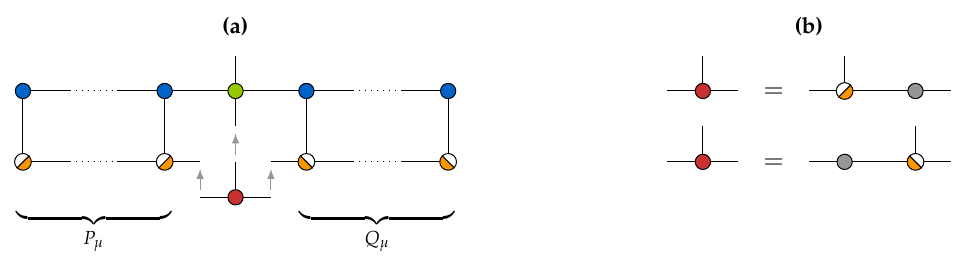
Figure 4. Construction and solution of the subproblem for the µ th core: ( a ) The 4-dimensional core of (cid:98) Ψ X , µ (green circle) is contracted with the matrices P µ and Q µ constructed by joining the fixed cores of the coefficient tensor (orange circles) with the corresponding cores of the transformed data tensor. The matricization then defines the matrix M µ . ( b ) The TT core (red circle) obtained by solving the low-dimensional minimization problem is decomposed (e.g., using QR factorization) into a orthonormal tensor and a triangular matrix. The orthonormal tensor then yields the updated core.